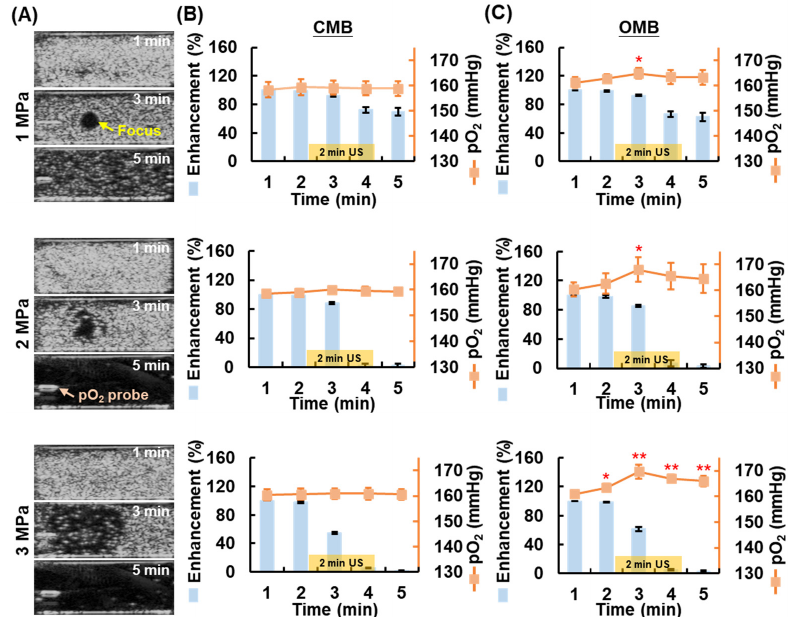
Figure 4. Local O 2 release from OMB disruption under HIFU sonication with various acoustic pres- sures (1, 2, and 3 MPa). ( A ) US imaging reveals OMB disruption at the focal position of HIFU (yellow arrow) during sonication (at 3 min), with non-contrast enhancement at 5 min after sonication under the acoustic pressure of 2 and 3 MPa, indicating total disruption of OMBs. The position of the pO 2 probe is indicated. The percentage of imaging contrast enhancement and corresponding pO 2 level during HIFU sonication in the ( B ) CMB and ( C ) OMB groups. The yellow blocks indicate the period of HIFU sonication. Notably, the US images at 2 min were captured before initiation of HIFU soni- cation (* p < 0.05, ** p < 0.01). The percentage imaging contrast enhancement after HIFU sonication with acoustic pressure of 1, 2, and 3 MPa decreased to 69.6 ± 5.2, 2.5 ± 2.1, and 1.9 ± 0.5%, respectively,